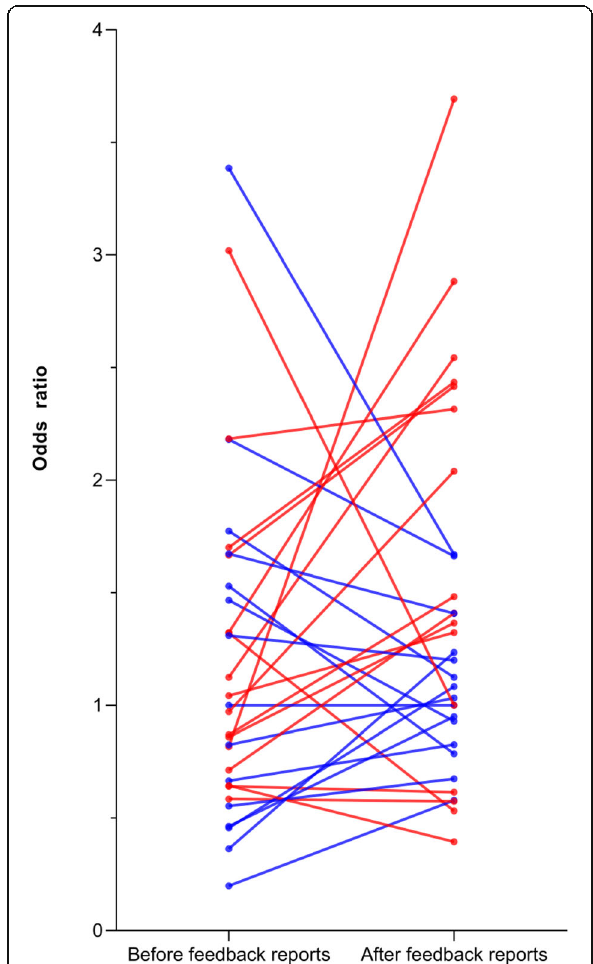
Fig. 3 Case-mix adjusted odds ratios per laboratory before and after the feedback reports were calculated by multivariate logistic regression analyses for grade III versus grade I-II ductal carcinoma in situ (DCIS). ORs are adjusted for tumor size and type of surgery. Each laboratory is represented by two dots (before and after feedback) connected by one line. The color of the line and dots shows whether the OR after feedback shifted towards an OR of 1.00, and thus became less deviant (blue) or the OR after feedback shifted away from an OR of 1.00, and thus became more deviant (red) from the reference